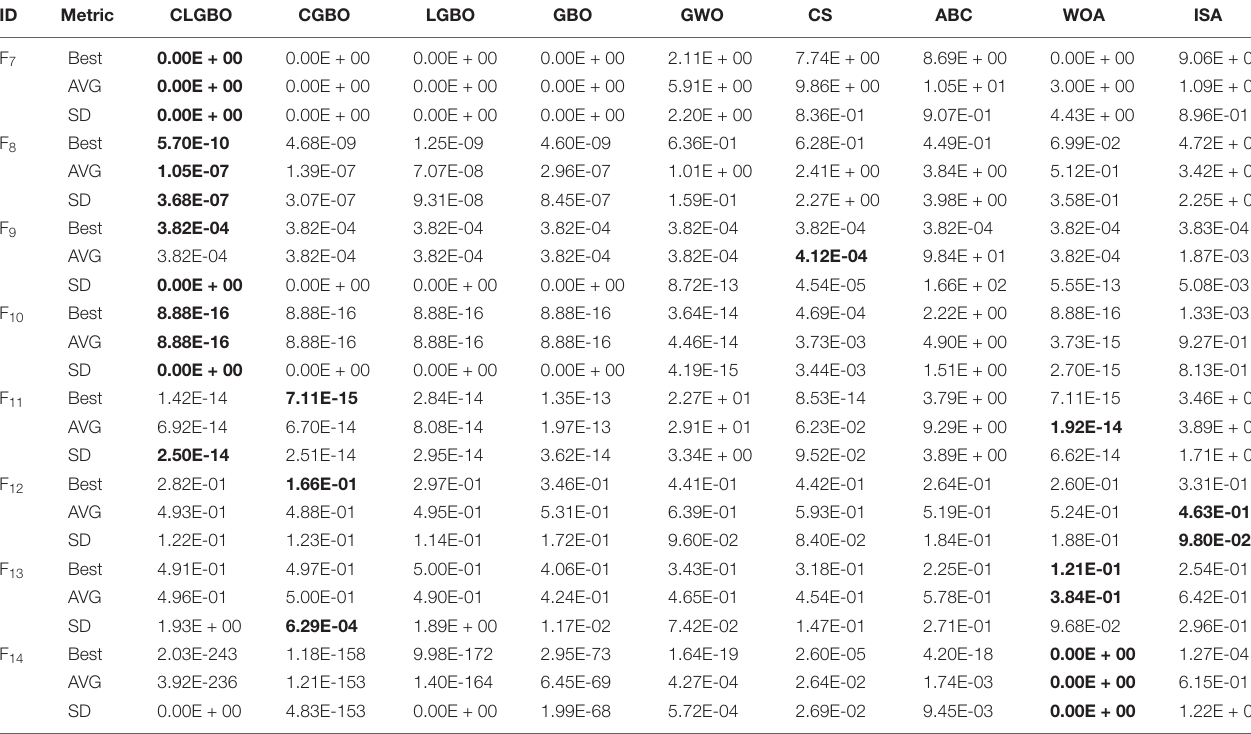
TABLE 3 | Results of the multimodal test